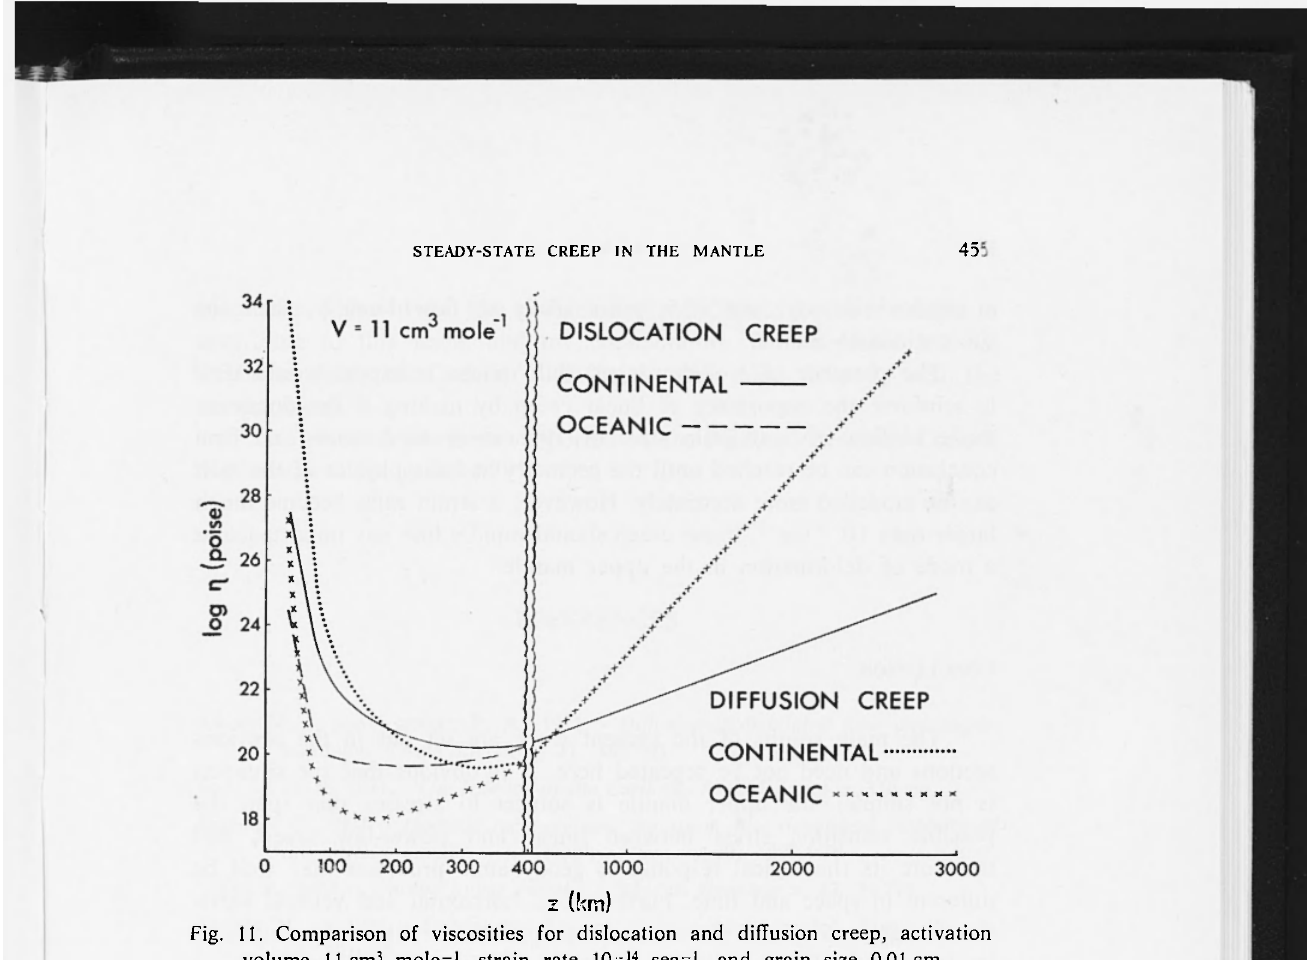
Fig. 11. Comparison of viscosities for dislocation and diffusion creep, activation